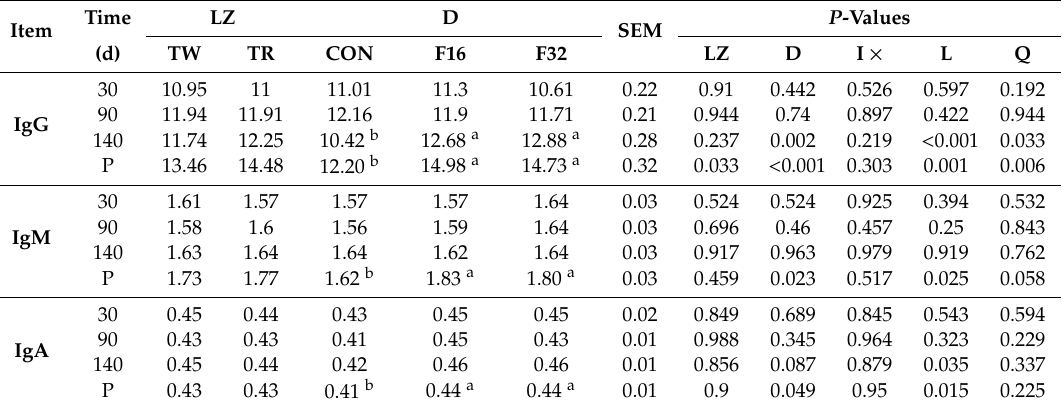
Table 5. Serum immunoglobulin concentration influenced by litter size and dietary FA levels (g / L).